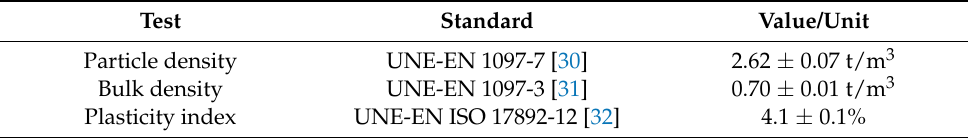
Table 1. Physical properties of limestone filler.